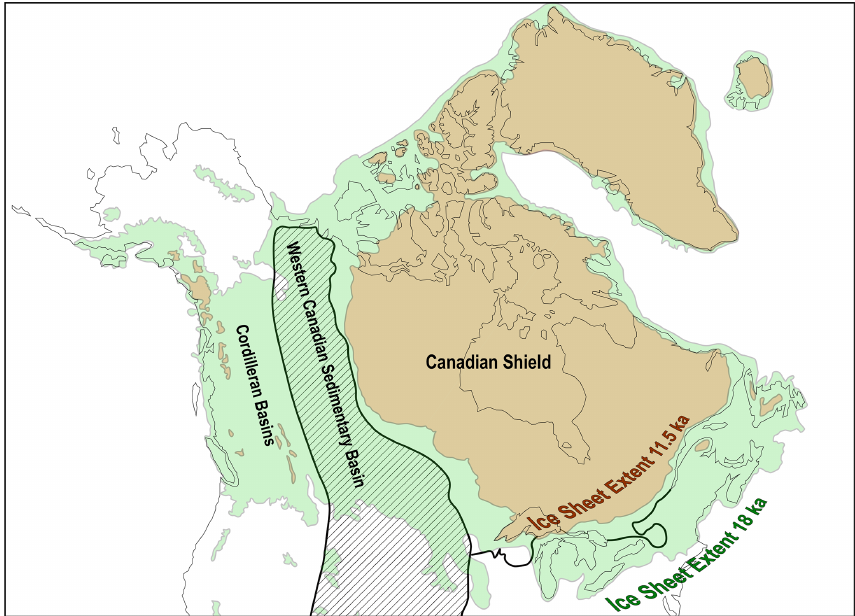
Figure 4. Laurentide Ice sheet extents bracketing the time span of the most pronounced glacial–interglacial CO 2 increase (redrawn after Dalton et al., 2020). The Western Canadian Sedimentary Basin (hatched area, with extension of related units into the United States) and the Cordilleran Basins are to the west of the Canadian Shield (simplified after Miall and Blakey, 2019). The southern border of the Canadian Shield is drawn with mainly Phanerozoic sedimentary units to the south (simplified after Reed et al., 2004). The surficial kerogen content in the Canadian Shield is generally low, while high kerogen contents are present along the axes of the Cordilleran Basins and Western Canadian Sedimentary Basin (see Fig. 2 in Copard et al., 2007). Less than or equal to 300 years after glacial retreat extended into the Canadian Shield, the rise in atmospheric CO 2 subsided (compare with Fig. 3). Here, kerogen oxidation in western Canada is hypothesized to have acted as a major source of CO 2 to the atmosphere in the direct wake of glacial